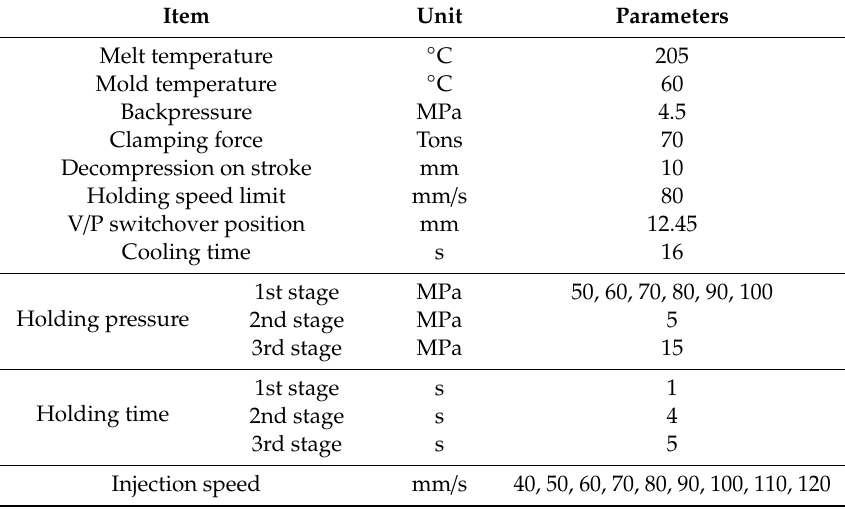
Table 3. Parameters of the injection molding process.